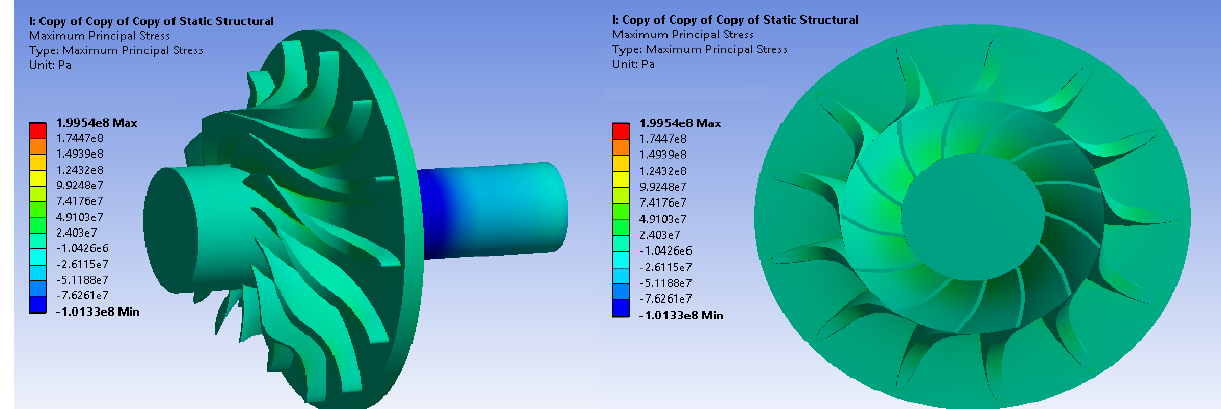
Figure 17. Maximum global stress (R134a).